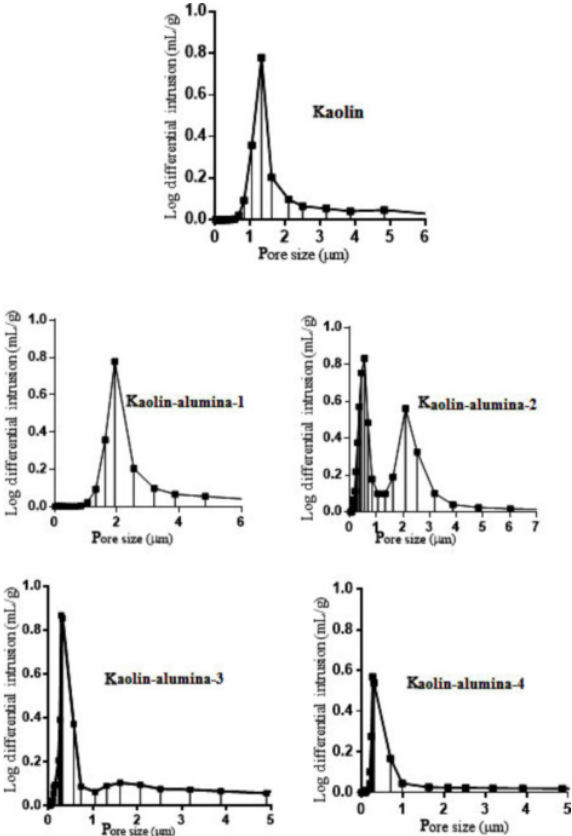
Fig. 9 Pore size distribution for membrane fabricated at different kaolin and kaolin/alumina ratio.